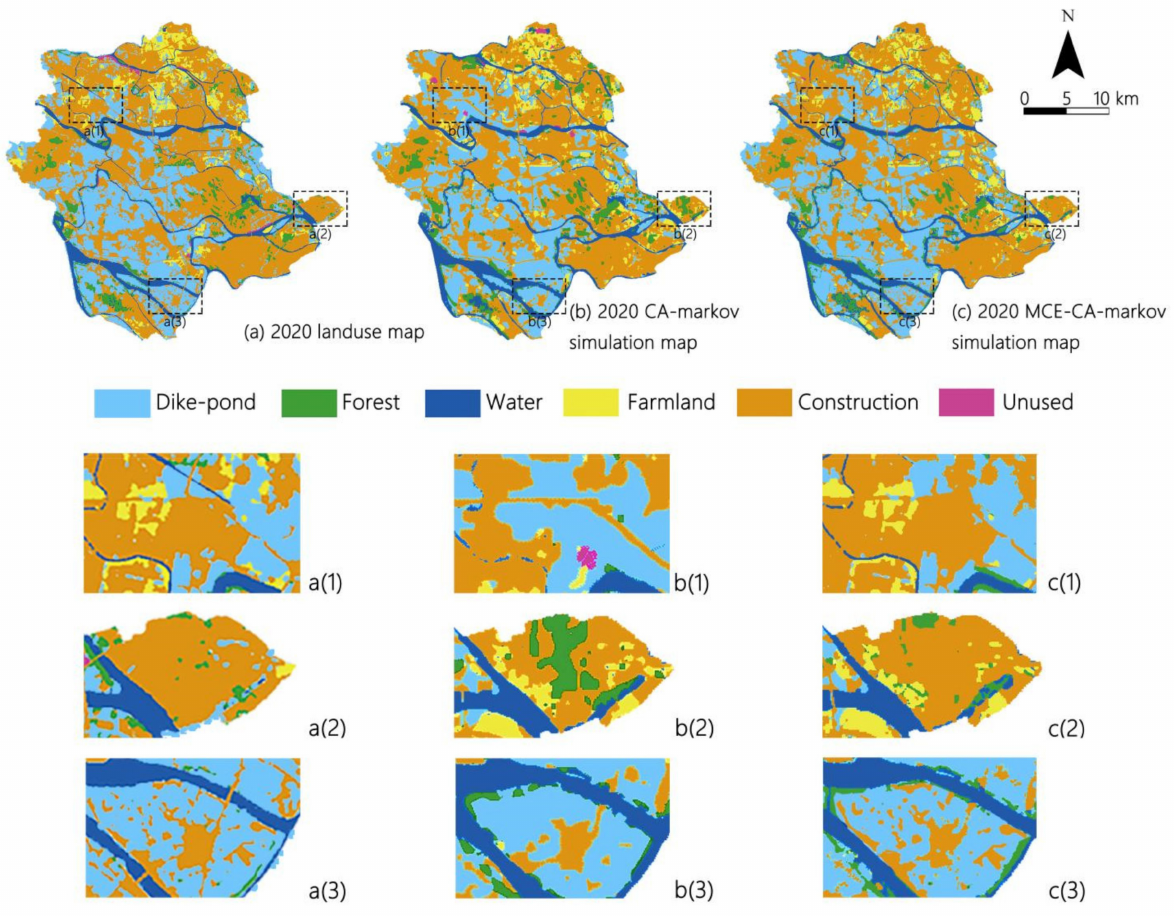
Figure 3. Comparison between predicted land use classification maps for 2020 ( a ), CA-Markov simulation map ( b ) and MCE-CA-Markov simulation map ( c ); a(1) , a(2) and a(3) are local enlarged images of ( a ); b(1) , b(2) and b(3) are local enlarged images of ( b ); c(1) , c(2) and c(3) are local enlarged images of ( c